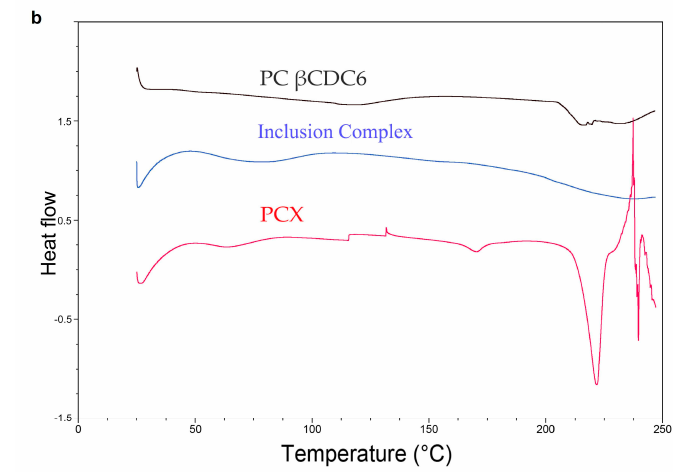
Figure 2. Differential Scanning Calorimetry (DSC) thermograms of Paclitaxel (PCX), 6OCapro β CD, PCX:6OCapro β CD inclusion complex ( a ) PC β CDC6 and PCX:PC β CDC6 inclusion complex ( b ).